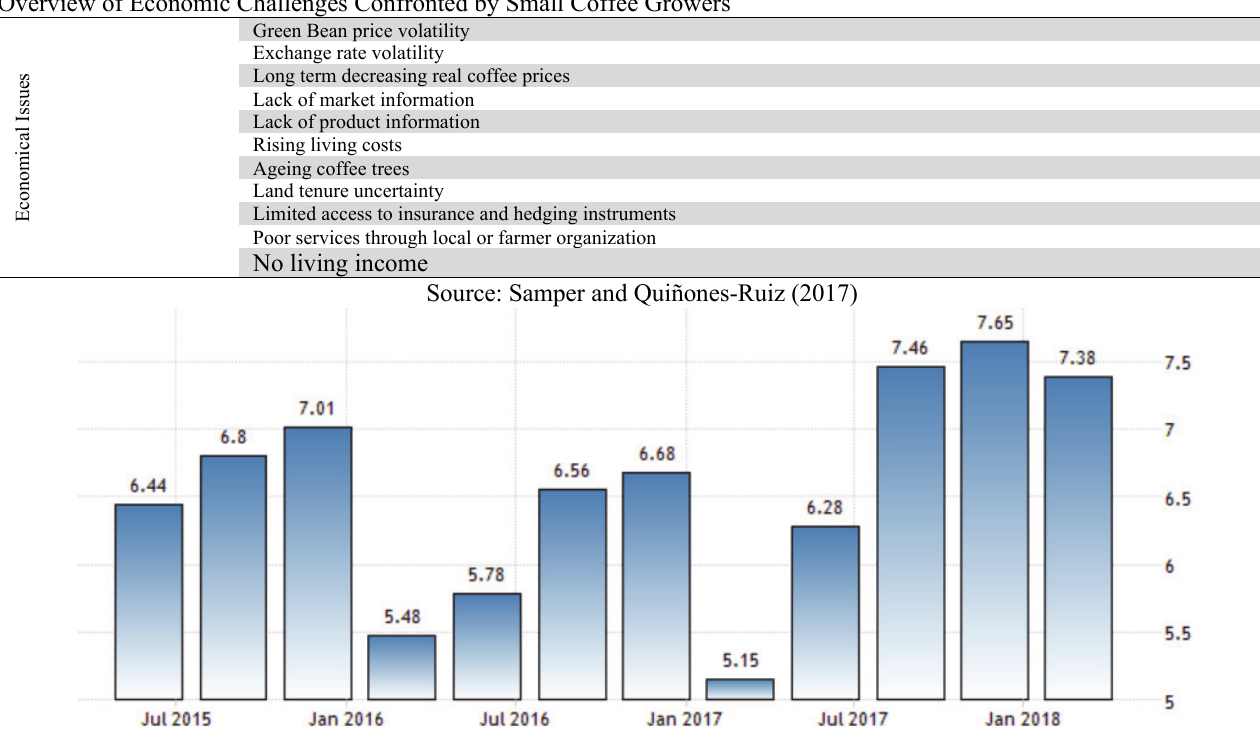
Fig. 1. GDP Growth Rate of Vietnam Source: International Coffee Council Report. (2019)